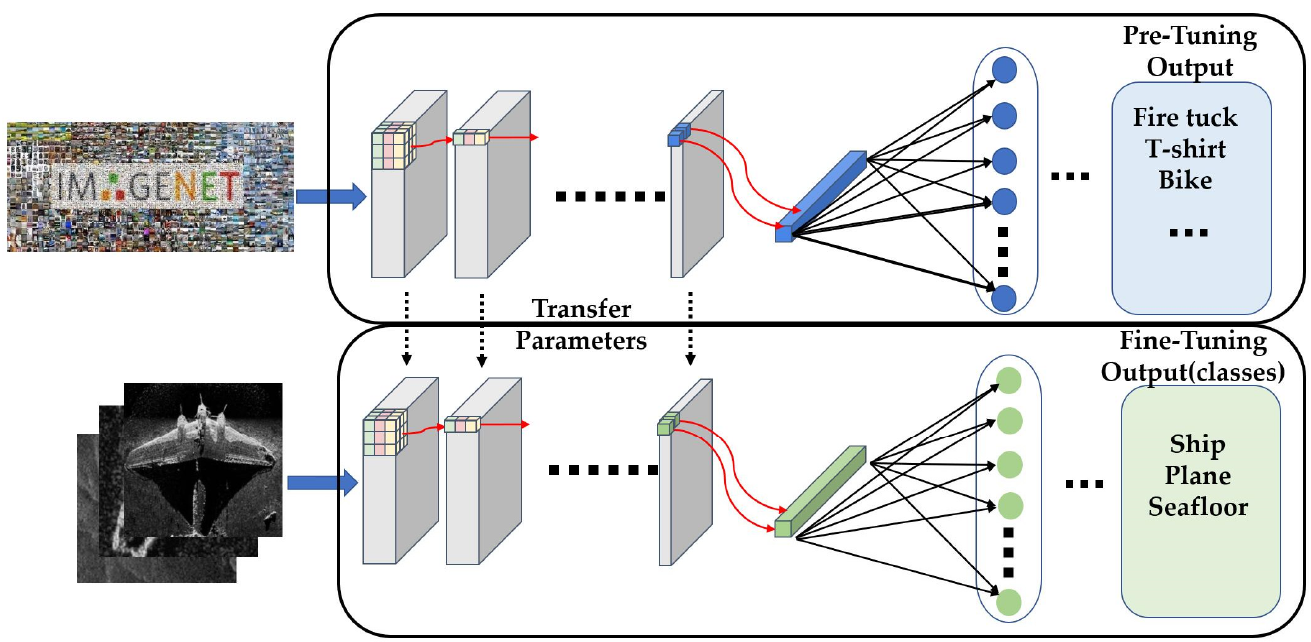
Figure 1. The architecture of fine-tuning the pre-trained CNN model initialized with the weights trained by ImageNet.